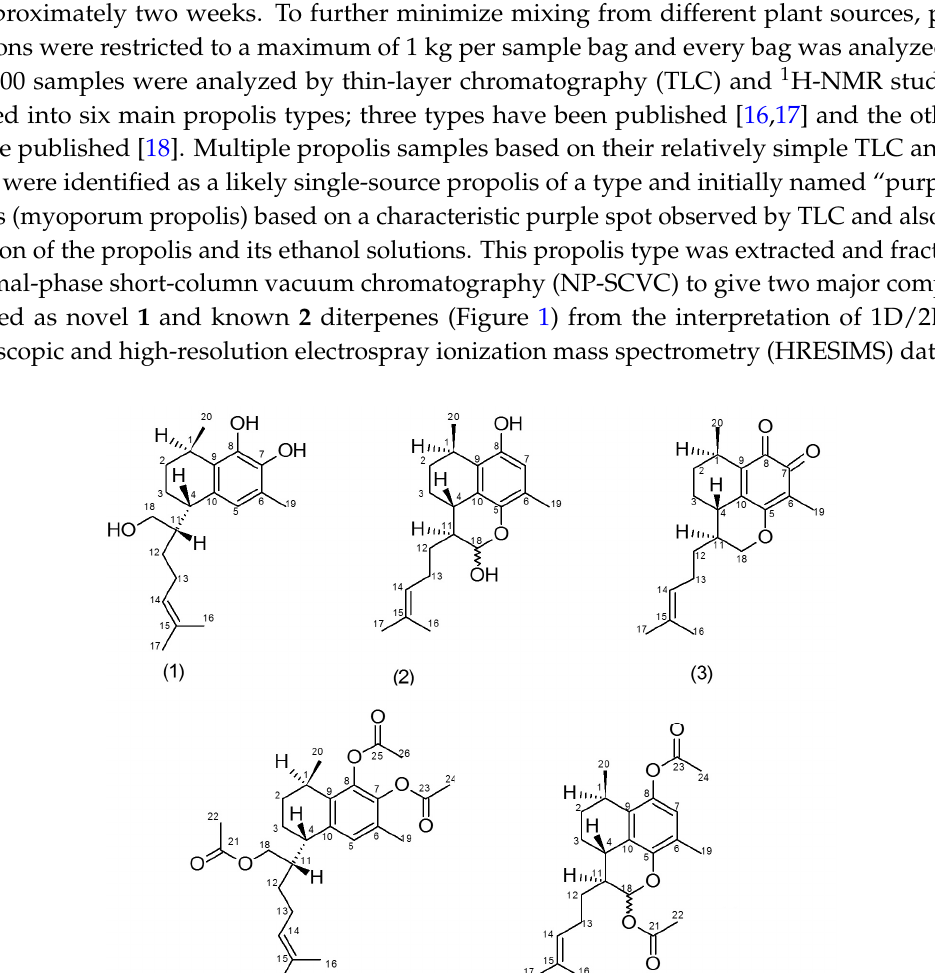
Table 1. 1 H-NMR data for Compounds 1–5 (400 MHz, δ in ppm J values (Hz) in parentheses, measured in CDCl 3 relative to tetramethylsilane (TMS)).